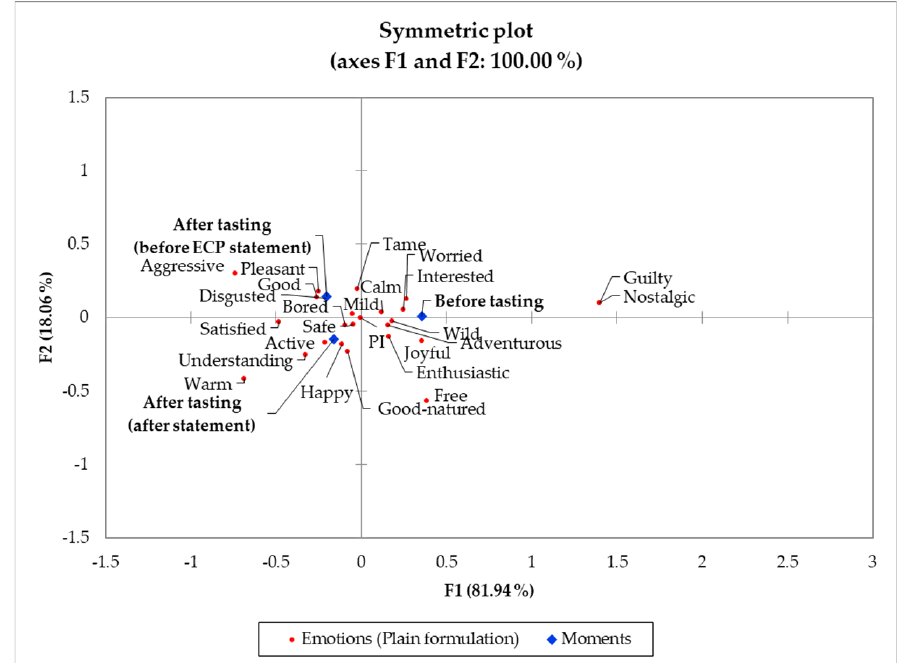
Figure 4. Correspondence analysis (chi-squared distance) symmetric plot visualizing the plain treatment moments (before tasting, after tasting, and after edible cricket protein (ECP) statement) and emotions from n = 84 consumers. Treatments are described in Figure 1.